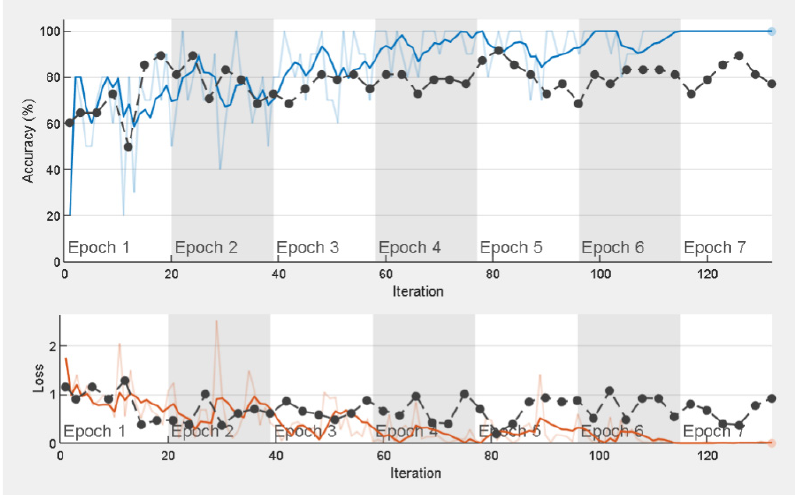
Figure 6. Training progress of ResNet-50 pretrained network.